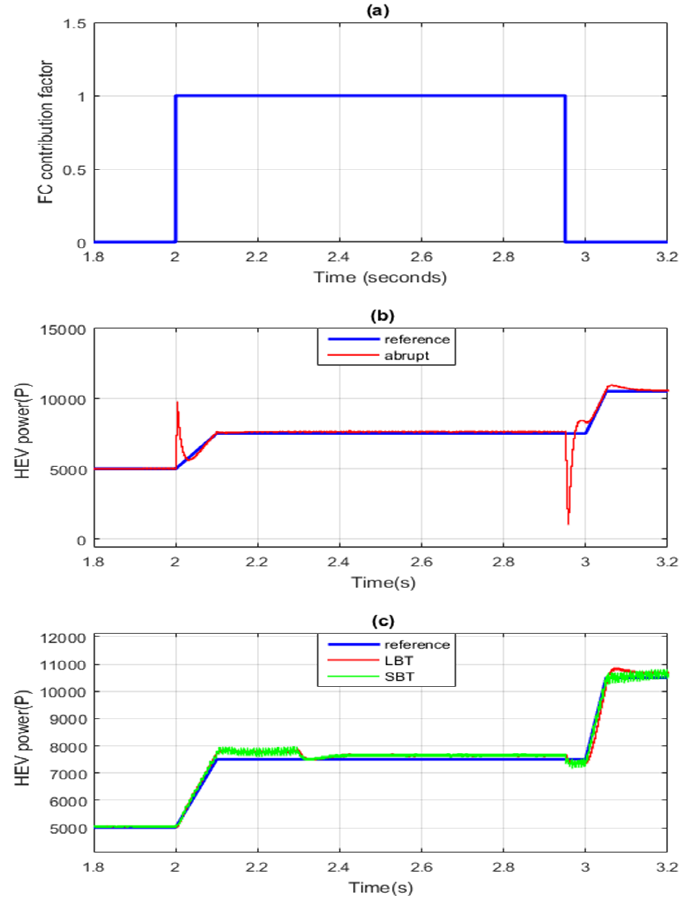
Figure 15. Zoom of HEV power. ( a ) Abrupt switching ( b ) SBT switching ( c ) LBT switching.